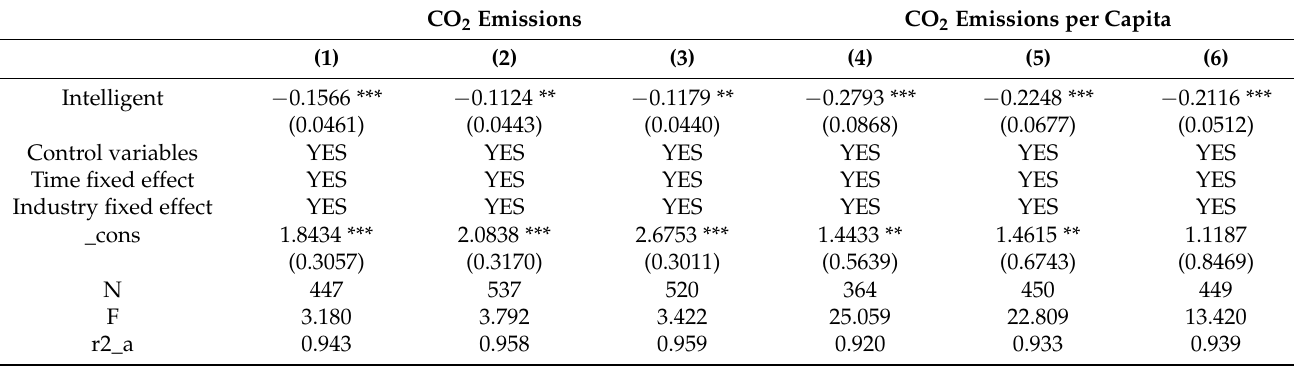
Table 8. Eliminating interference